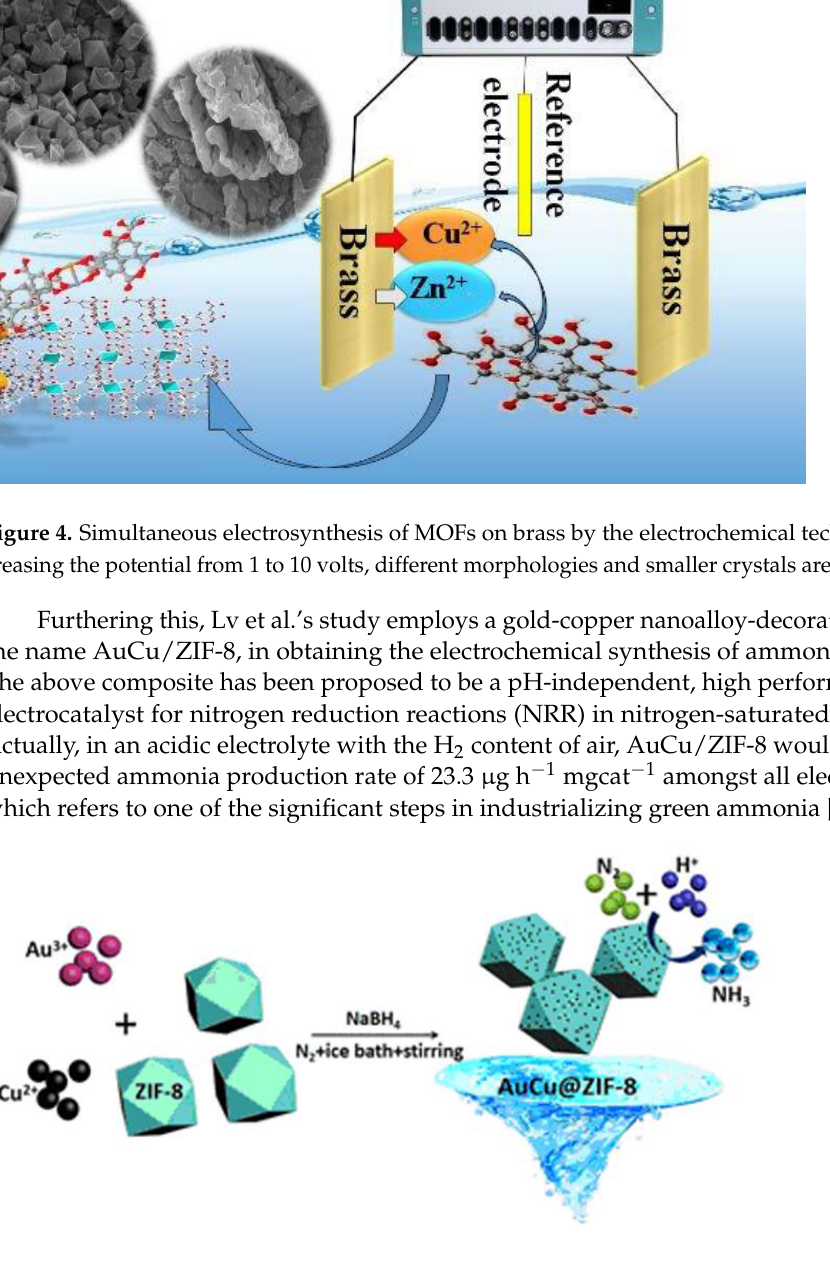
Figure 5. Schematic synthesis of AuCu/ZIF-8 by a one-step synthetic path for obtaining the electro- chemical synthesis of ammonia [111].